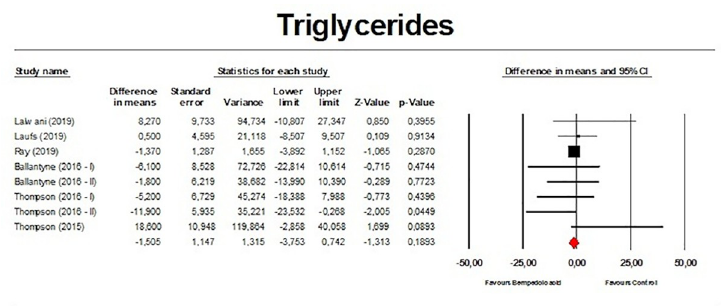
Fig 10. Forest plot displaying mean difference and 95% confidence intervals for the effect of bempedoic acid on plasma levels of triglycerides.